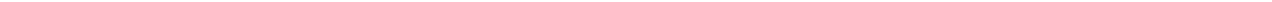
Fig. 8 Dysbindin overexpression increases release of EGTA-sensitive vesicles that are required for PHP. a Immunostaining of a larval NMJ (muscle 6/7) overexpressing venus-dysbindin presynaptically. Venus-Dysbindin was detected with anti-GFP (aGFP), neuronal membrane with an antibody against horseradish peroxidase (aHRP); scale bar = 5 µ m. b Representative EPSCs of controls ( elav C155 ) and after presynaptic venus-dysbindin